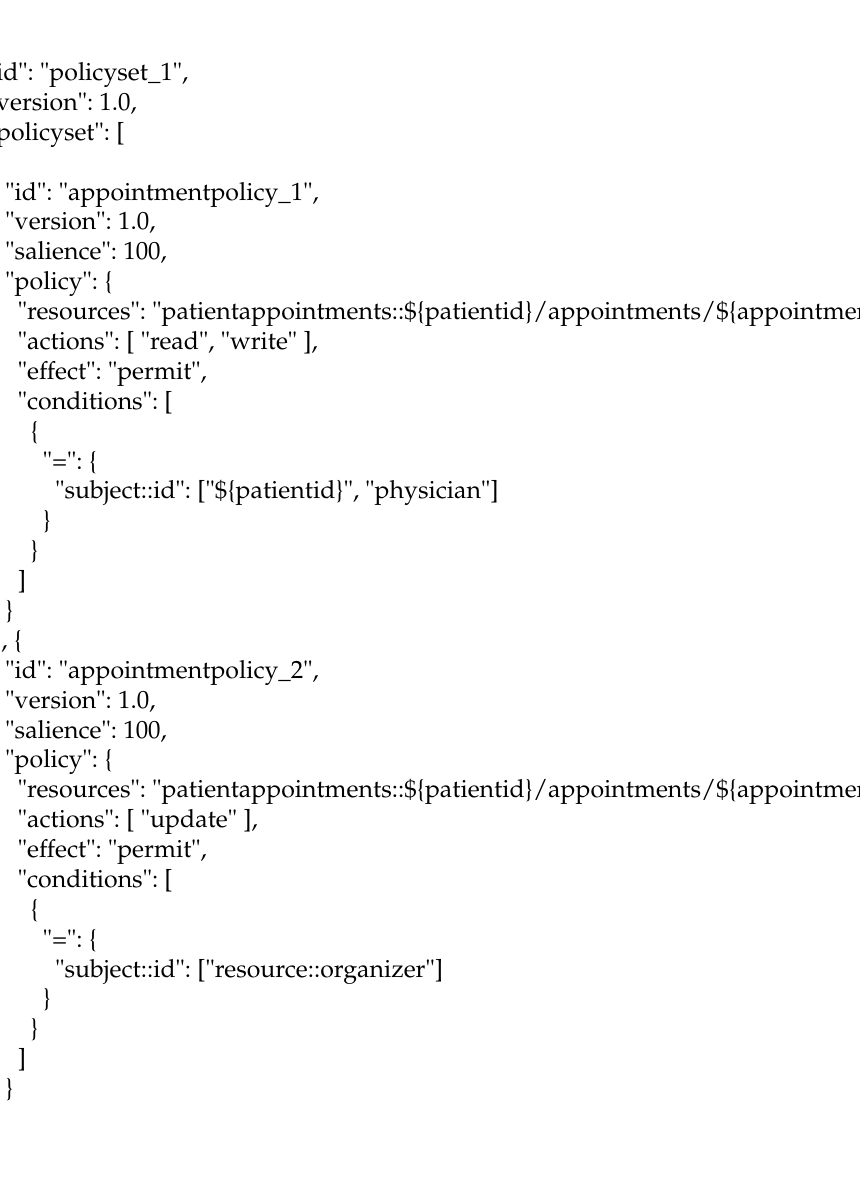
Figure 11. Authorization policy for the Patient Appointment